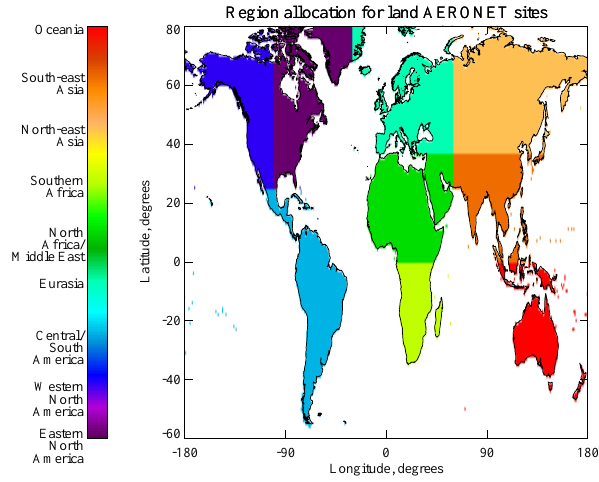
Fig. 1. Geographical bounds of land regions used in this study for comparison of SeaWiFS AOD with other